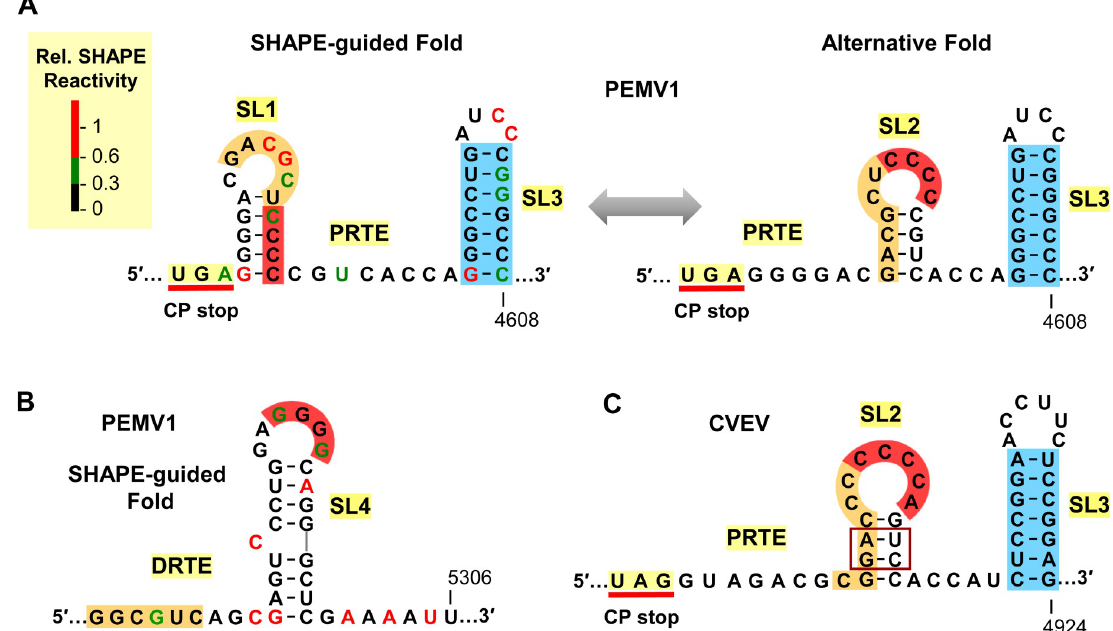
Fig 2. SHAPE-guided RNA secondary structures of PRTE and DRTE. (A) SHAPE-guided and alternative folds for the PRTE in PEMV1. Relative SHAPE reactivities of individual nucleotides are colour-coded (see key) in the SHAPE-guided fold (left). The CP stop codon, SL1, and SL3 are labeled. An alternative fold in which SL2 forms is shown on the right, with a double-headed arrow depicting the proposed interconversion between the two conformations. The stem of SL3 is highlighted in blue, while orange and red highlights denote sequences that have complementary partner segments in the DRTE, which is shown in panel B. (B) SHAPE-guided fold of DRTE in PEMV1. Nucleotide reactivities are colour-coded and segments complementary to red and orange RNA segments in the PRTE are indicated. (C) SL2 and SL3 PRTE equivalents predicted in citrus vein enation virus (CVEV, NC_021564), with corresponding orange, red, and blue segments